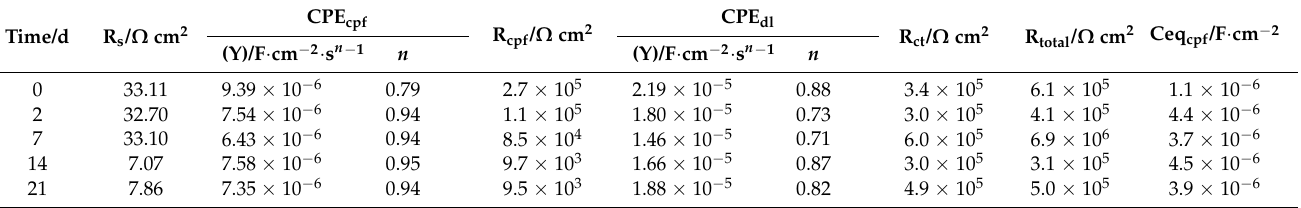
Table 3. EIS fitting parameters of